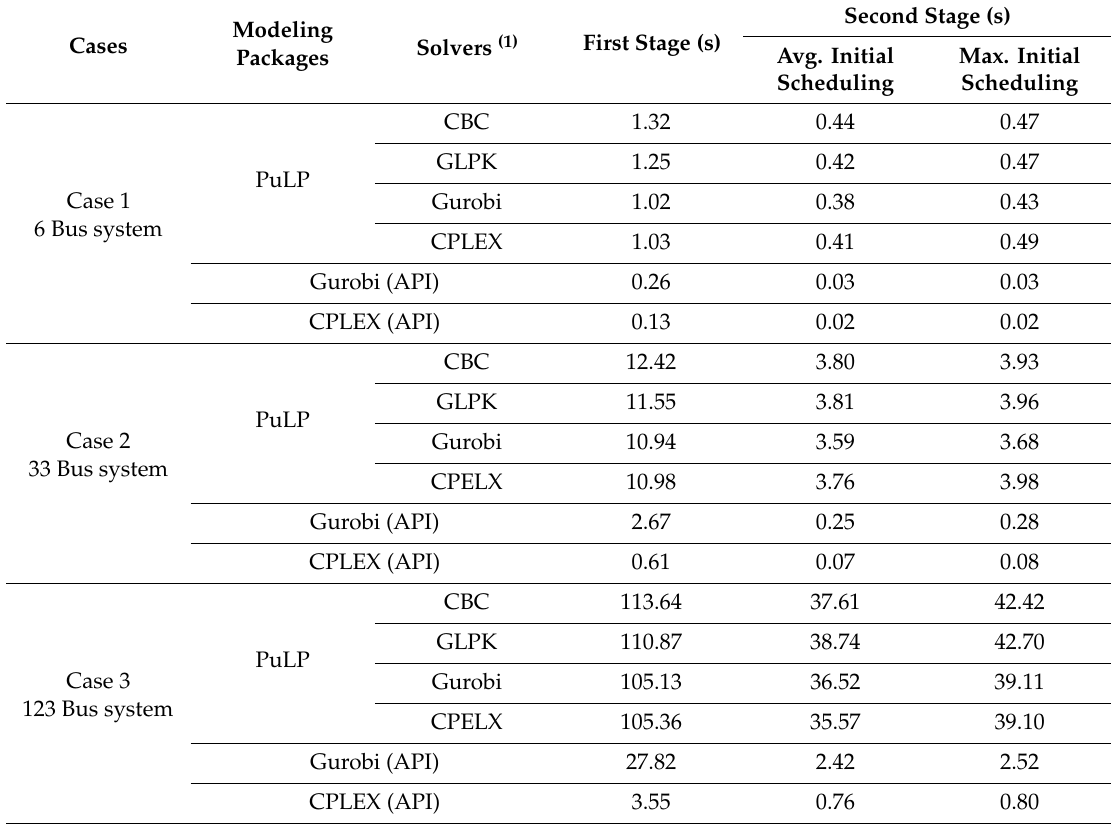
Table 6. Computation times of the optimization